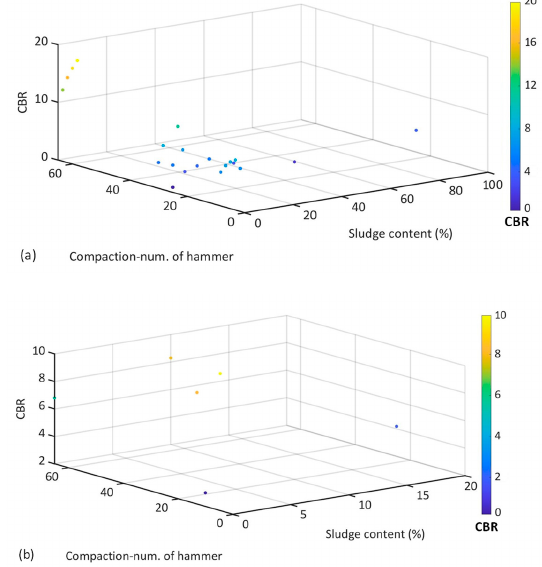
Figure 6. Distribution of ( a ) training and ( b ) testing databases. Table 2. The statistical information of the training database.